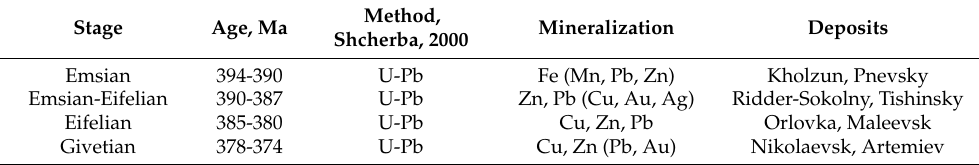
Table 1. Geochronology and stratigraphic levels of VMS mineralization in Rudny Altai.